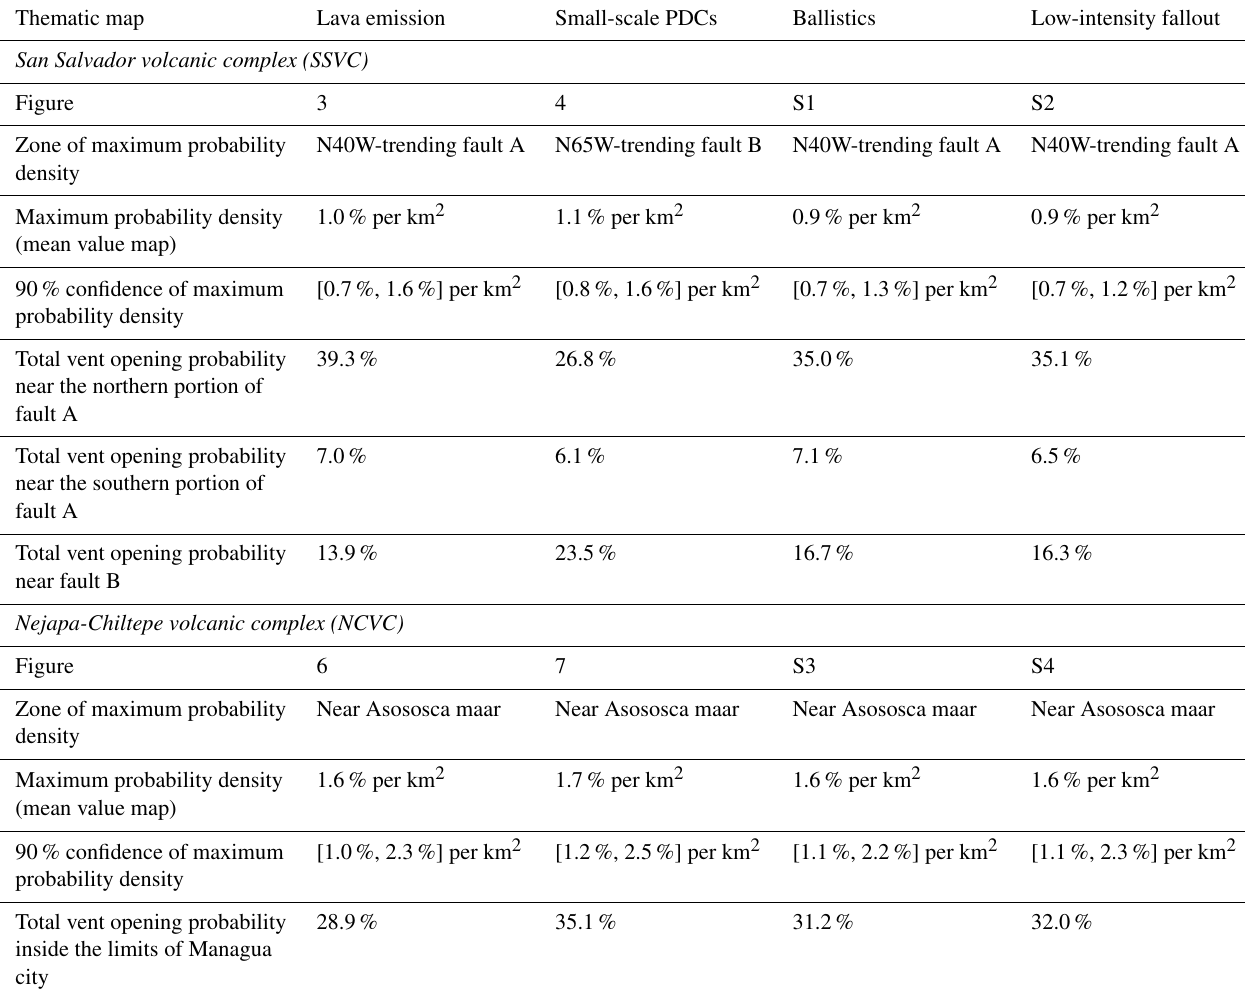
Table 3. Summary of the main features of the vent opening probability maps presented in this work. Thematic map Lava emission Small-scale PDCs Ballistics Low-intensity